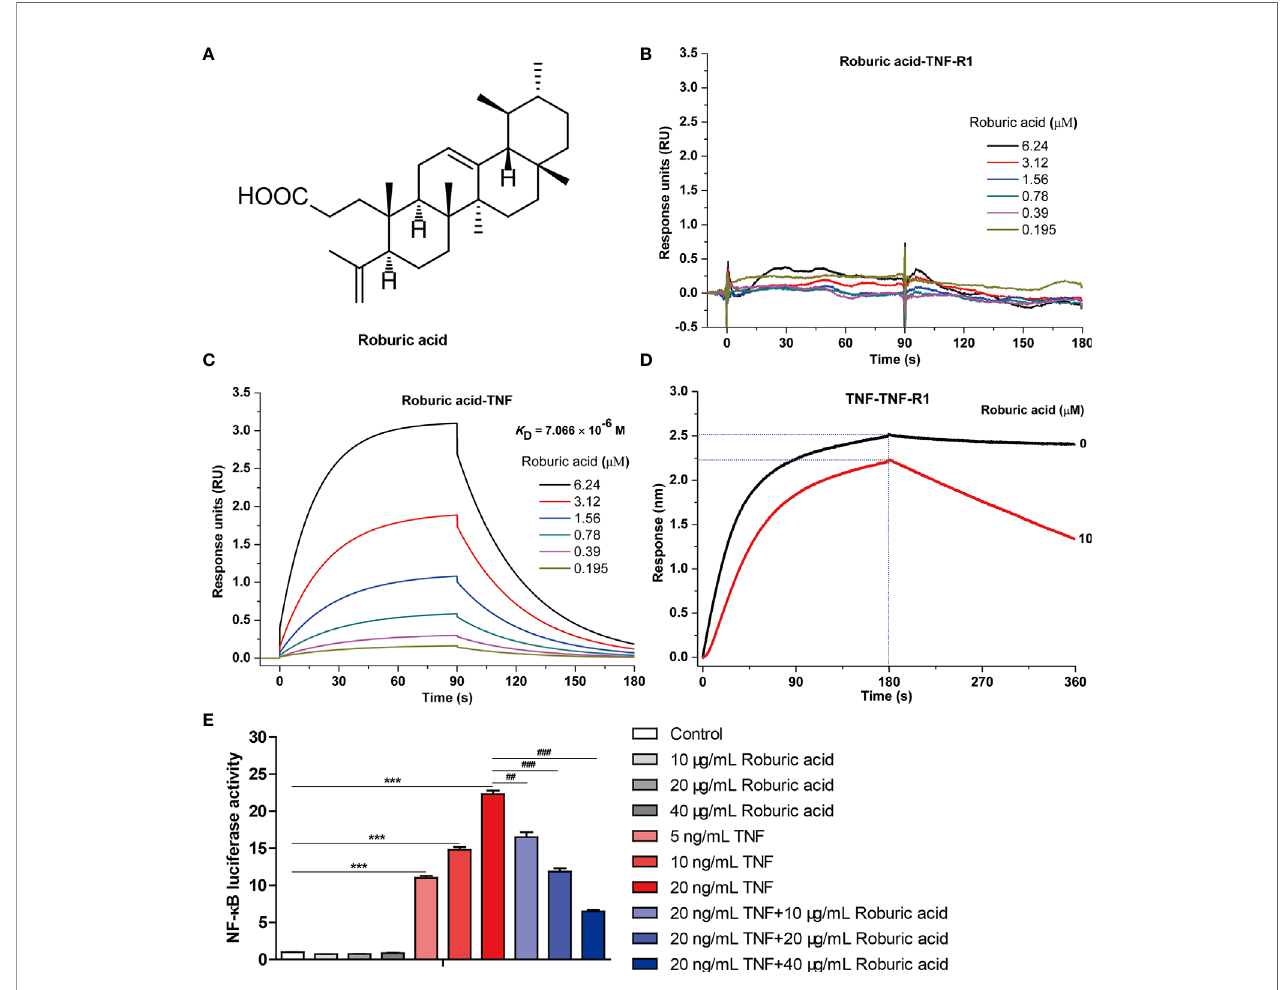
FIGURE 1 | Roburic acid disrupts the interaction between TNF and TNF-R1 and blocks TNF-induced NF- k B activation. (A) The chemical structure of roburic acid. Direct interactions between roburic acid and TNF-R1 (B) and TNF (C) were detected using SPR analysis. (D) Roburic acid disrupts the interaction between TNF and TNF-R1, as determined by a BLI-based solution competition assay. (E) Roburic acid blocks TNF-induced NF- k B activation. Luciferase reporter assays were used to detect the NF- k B activity in 293-TNF Res (NF- k B) cells. Data are shown as means ± SEM of three independent replicates. *** P < 0.001 compared with the control; ## P < 0.01 and ### P < 0.001 compared with TNF treatment